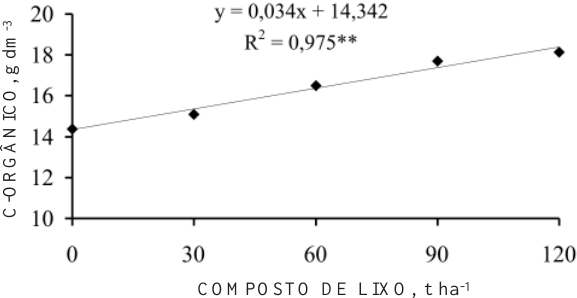
Figura 3. C-orgânico no solo, considerando as doses de composto de lixo urbano.